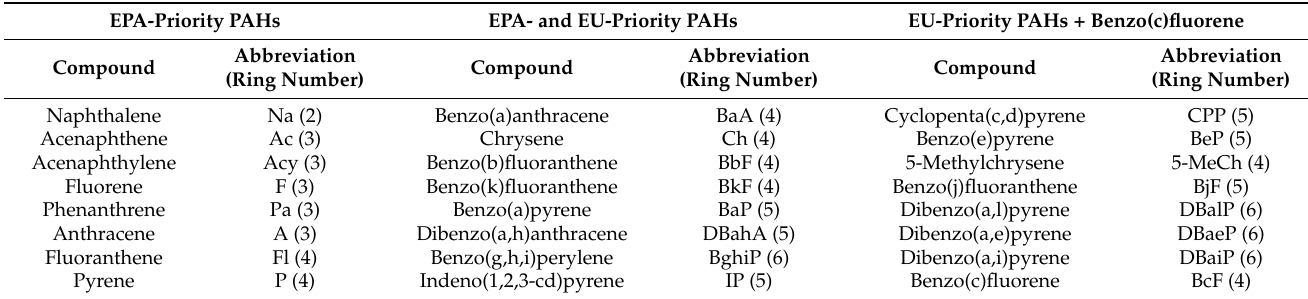
Table 1. Names and abbreviations of Environmental Protection Agency (EPA)- and EU- priority polycyclic aromatic hydrocarbons